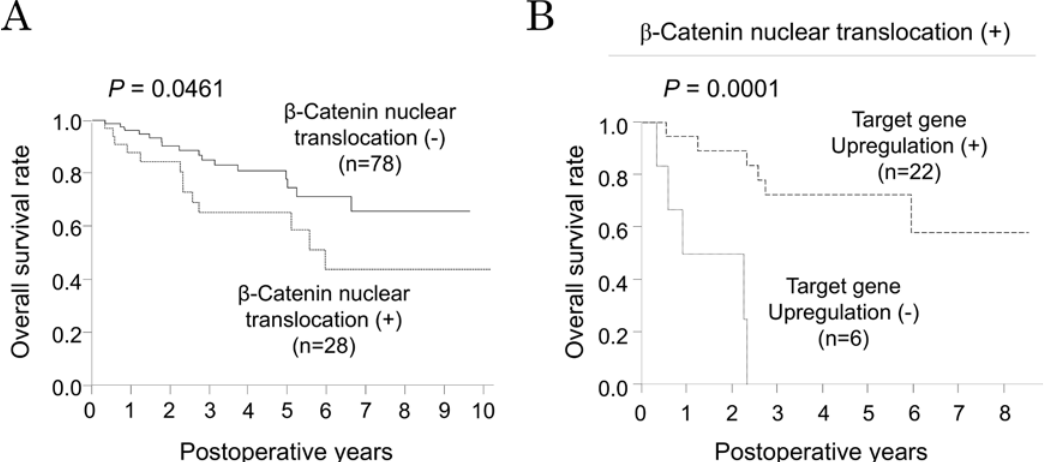
Fig 4. Prognostic impact of β -catenin signaling in human HCC. A. Overall survival is compared between patients with β -catenin nuclear translocation in tumor (n = 28) and patients without it (n = 78). B. Overall survival was compared between patients with described target gene upregulation (n = 22) and others without it (n = 6) in patients with β -catenin nuclear